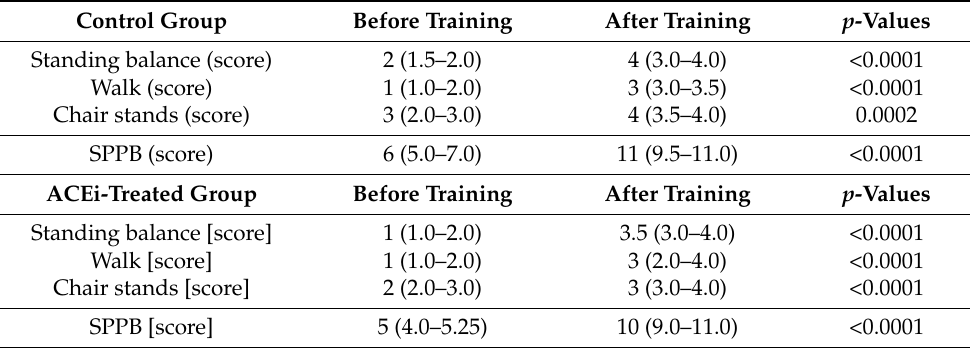
Table 3. Performance test scores for Short Physical Performance Battery (SPPB)